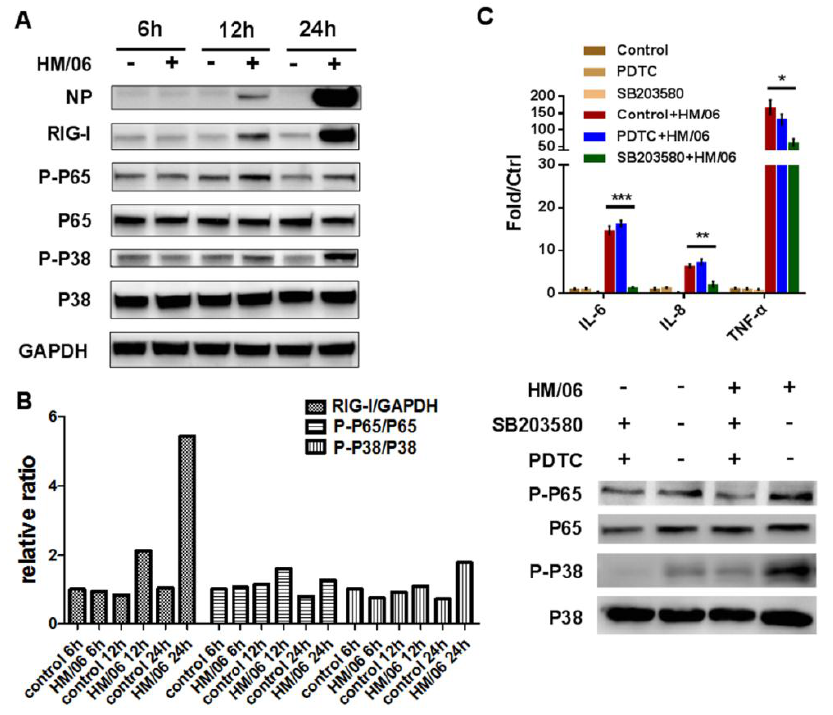
Figure 9. Viral infection increased phosphorylation of p65 and p38 in U251. ( A ) Infected and control cells were lysed in Tris lysis buffer (Cell Signaling) for western blot using corresponding antibodies; ( B ) ImageJ was used for intensity analysis of western blot; ( C ) Cellswere pretreated withNF-κB inhibitor PDTC and p38 kinase inhibitor SB203580 with 100 μM and 5 μM respectively followed by HM/06 infection. At 24 hpi, RNA and protein were collected for qRT-PCR and western blot using corresponding antibodies. For RT-PCR, IL-6, IL-8, and TNF-α were tested with GAPDH as normalization. Data was mean ± SEM. Statistical significance was analyzed by student’s t test. * p < 0.05, ** p <